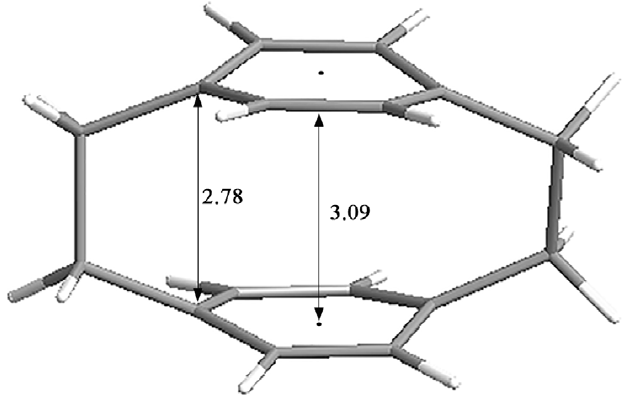
Figure 1. Strain and structural parameters in ångstroms [Å] of PCP.